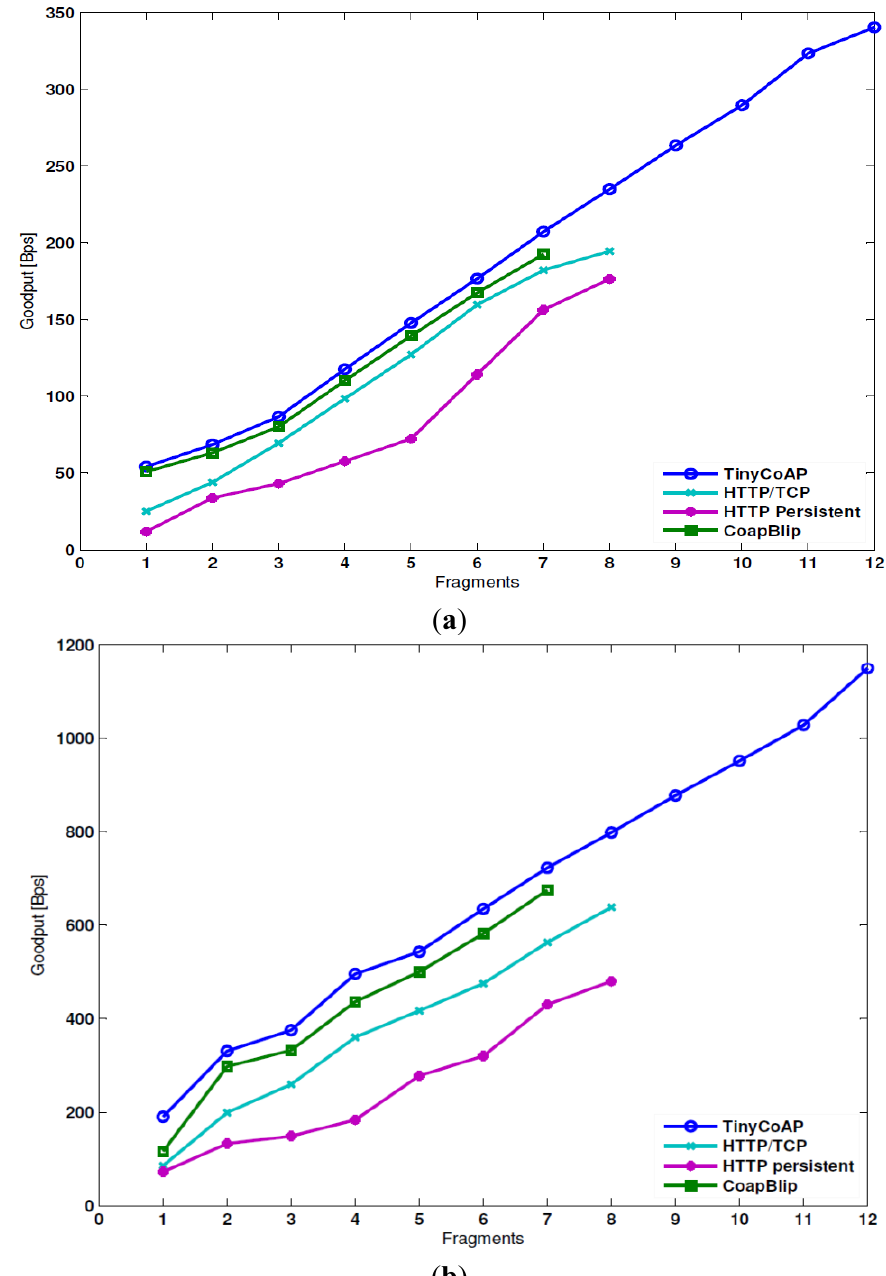
Figure 10. Goodput evolution in a channel under the Rayleigh fading model. ( a ) Goodput with SNR of 1 dB; ( b ) Goodput with SNR of 1.5 dB; ( c ) Goodput with SNR of 1.5